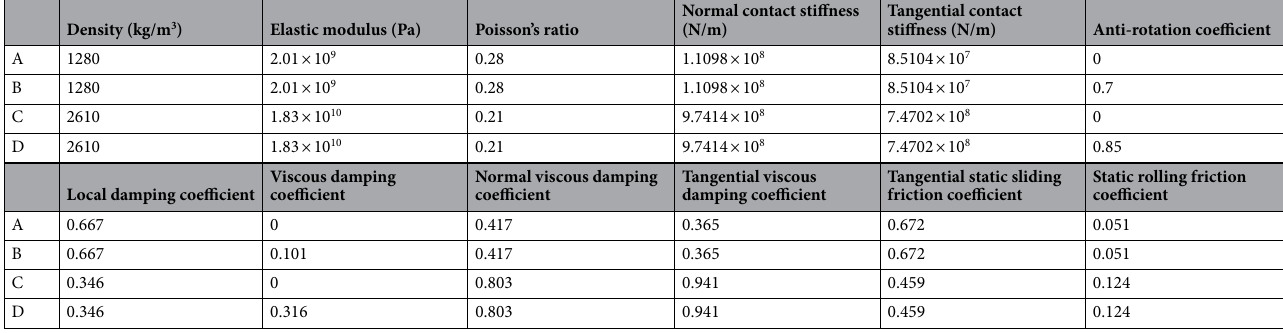
Table 1. Parameters of coal and rock